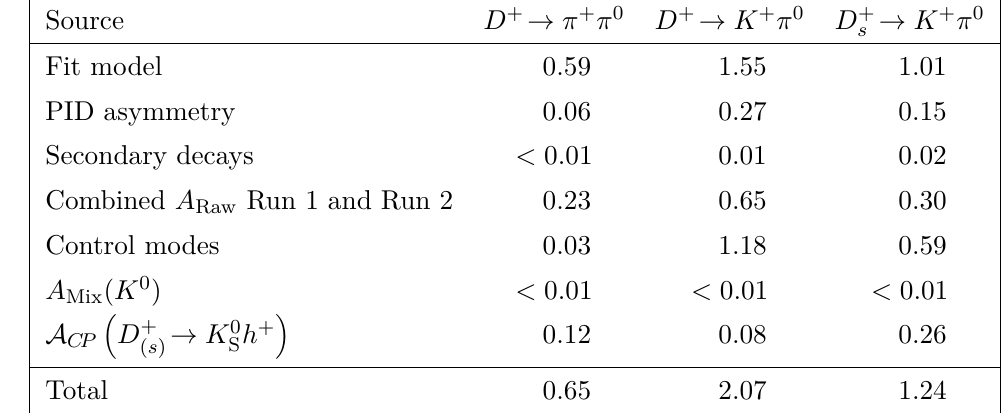
Table 3. Absolute systematic uncertainties (%) on the CP asymmetries for D +